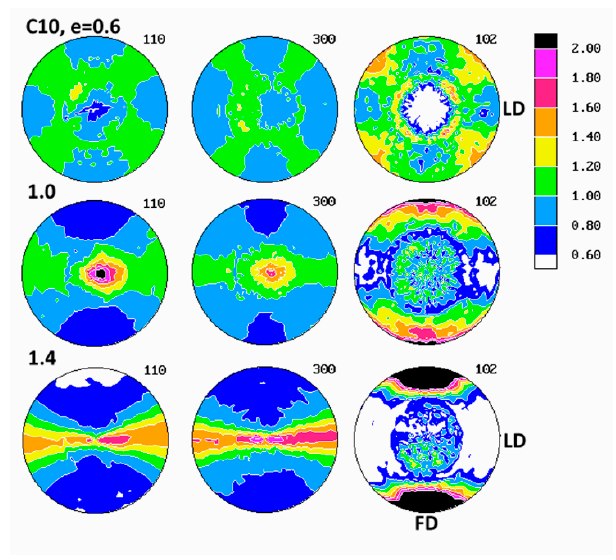
Figure 10. Selected normalized pole figures of the (110) (300) and (102) crystallographic planes (Form I) determined for samples of C10 copolymer compressed in plane-strain to the true strain indicated.